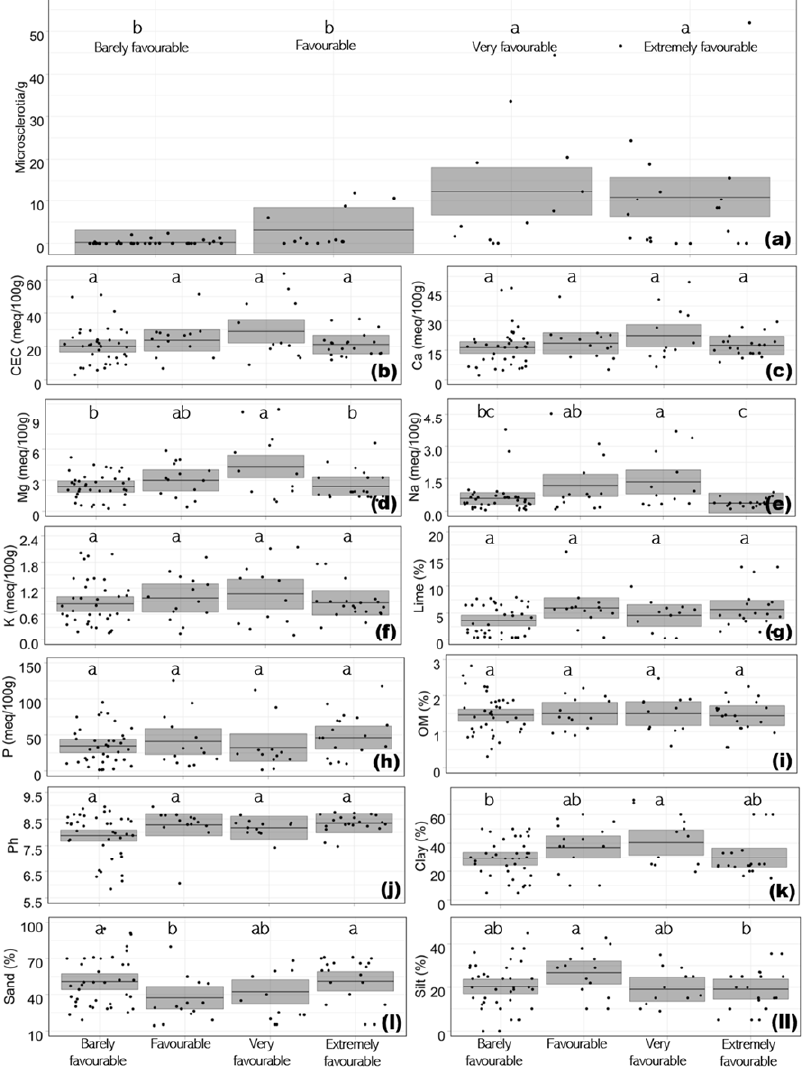
Figure 3. Raw values of inoculum density of Verticillium dahliae in soil ( a ) and cation exchange capacity (CEC; ( b )), Ca exchange (Ca; ( c )), Mg exchange (Mg; ( d )), Na exchange (Na; ( e )), K exchange (K; ( f )), assimilable P (P; ( g )), active limestone (lime; ( h )), organic matter (OM; ( i )), pH ( j ), and percentage of clay ( k ), sand ( l ), and silt ( ll ) raw values from 84 samples collected in the Iberian Peninsula and the mean from the linear mixed model with 95% confidence intervals per previous cropping history group (VWO which was barely favourable with <2 host crops to V. dahliae in the previous five years; VWO which was favourable with 3 host crops of the fungus; VWO which was very favourable and indicated that only one of the previous five years of the plot was free of V. dahliae hosts; and VWO which was extremely favourable and indicated that during all the five previous years species susceptible to V. dahliae were cropped in the plot) and grouping letters (Treatments with a common lowercase letter do not differ significantly according to Tuckey test at p =